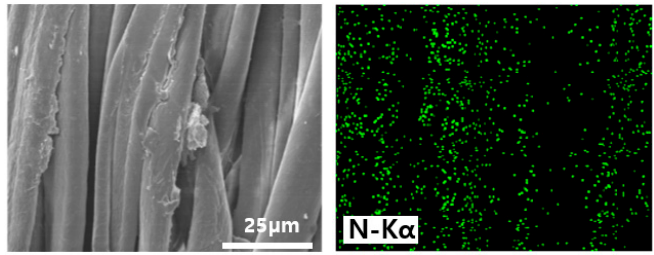
Figure 9. EDS mapping of the nitrogen element for the Gu-chitosan-treated cotton fabric.